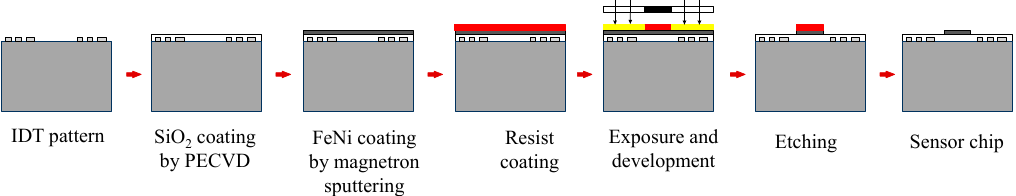
Figure 6. The technological process of SAW current sensor chip. IDT: interdigital transducer; PECVD: plasma enhanced chemical vapor deposition.